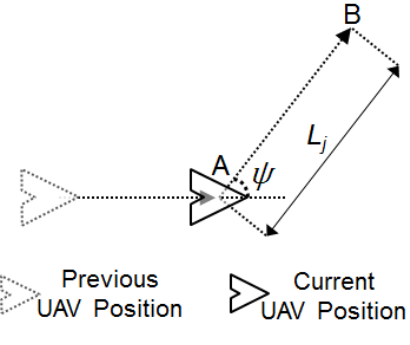
Figure 4. Unmanned aerial vehicles’ movement step and